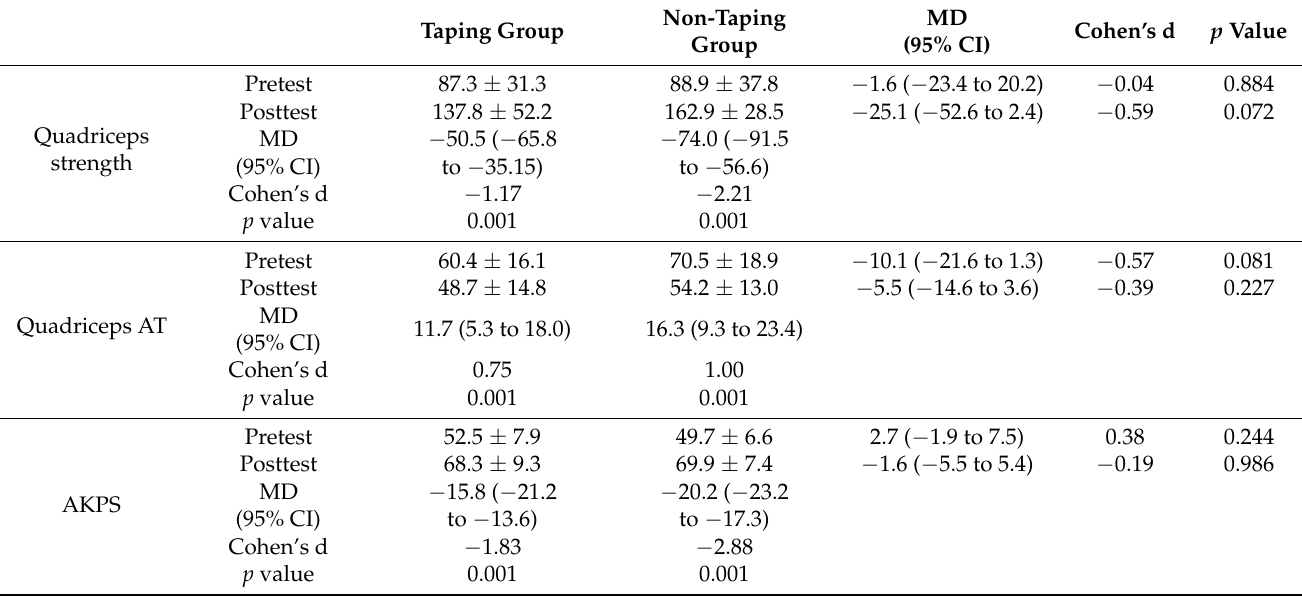
Table 2. Functional outcomes comparison between the